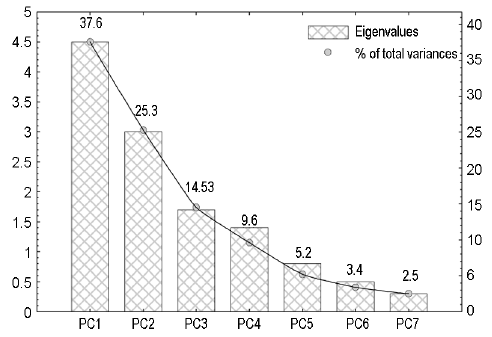
Fig. 9. Architecture of the developed ANN model for predicting the pile capacity Fig. 8. Eigenvalues and contributions of components to the